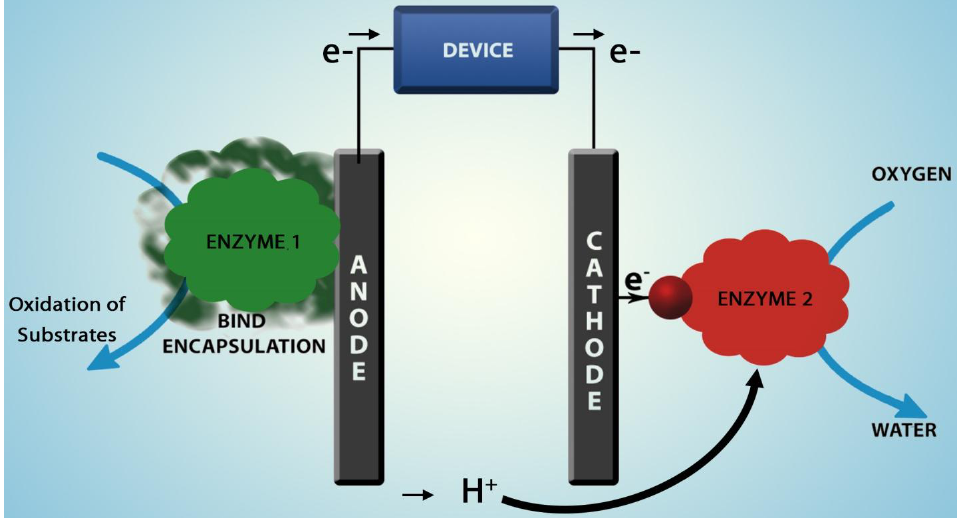
Figure 8. Enzymatic fuel cell schematic. Enzymatic fuel cell use enzymes as the biocatalysts to oxidize organic fuels and transfer the electrons through either direct electron transfer (DET) or mediated electron transfer (MET) to the anode. DET is the process where electrons can tunnel directly from the enzyme redox centers to the electrodes. MET, on the other hand, uses mediator molecules to shuttle electrons from the enzyme to the electrode. The electrons are used to power a load and are collected at the cathode where they participate in reduction reactions. Enzymatic fuel cells have fewer design constraints than MFCs since the enzymes do not have to work in anaerobic environment. As such, EFC’s system designs do not require a